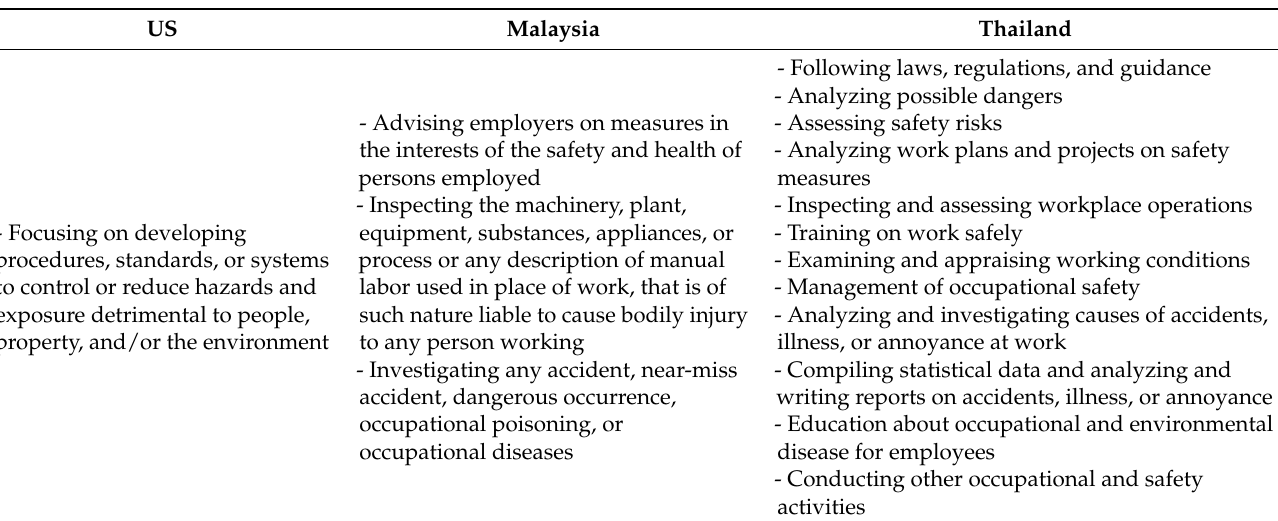
Table 4. Duties of safety